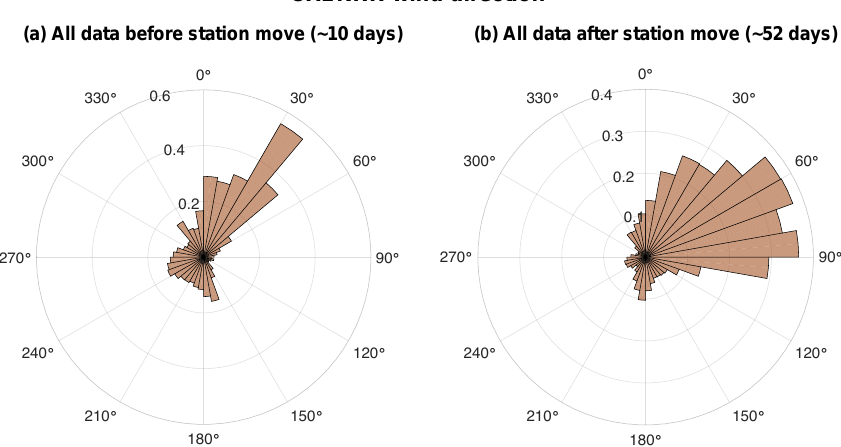
created 23-Aug-2017 15:58:25 Figure 11. Rose diagrams of all data collected before (a) and after (b) the CXENRR station was moved on 5 February 2016. Sector lengths are proportional to the square root of the relative frequency of that 10 ◦ bin, so the area of each sector is proportional to that bin’s frequency. All data before the move are 2min averages; there are about 5.25 days of such data after the move, and thereafter the data are 1min